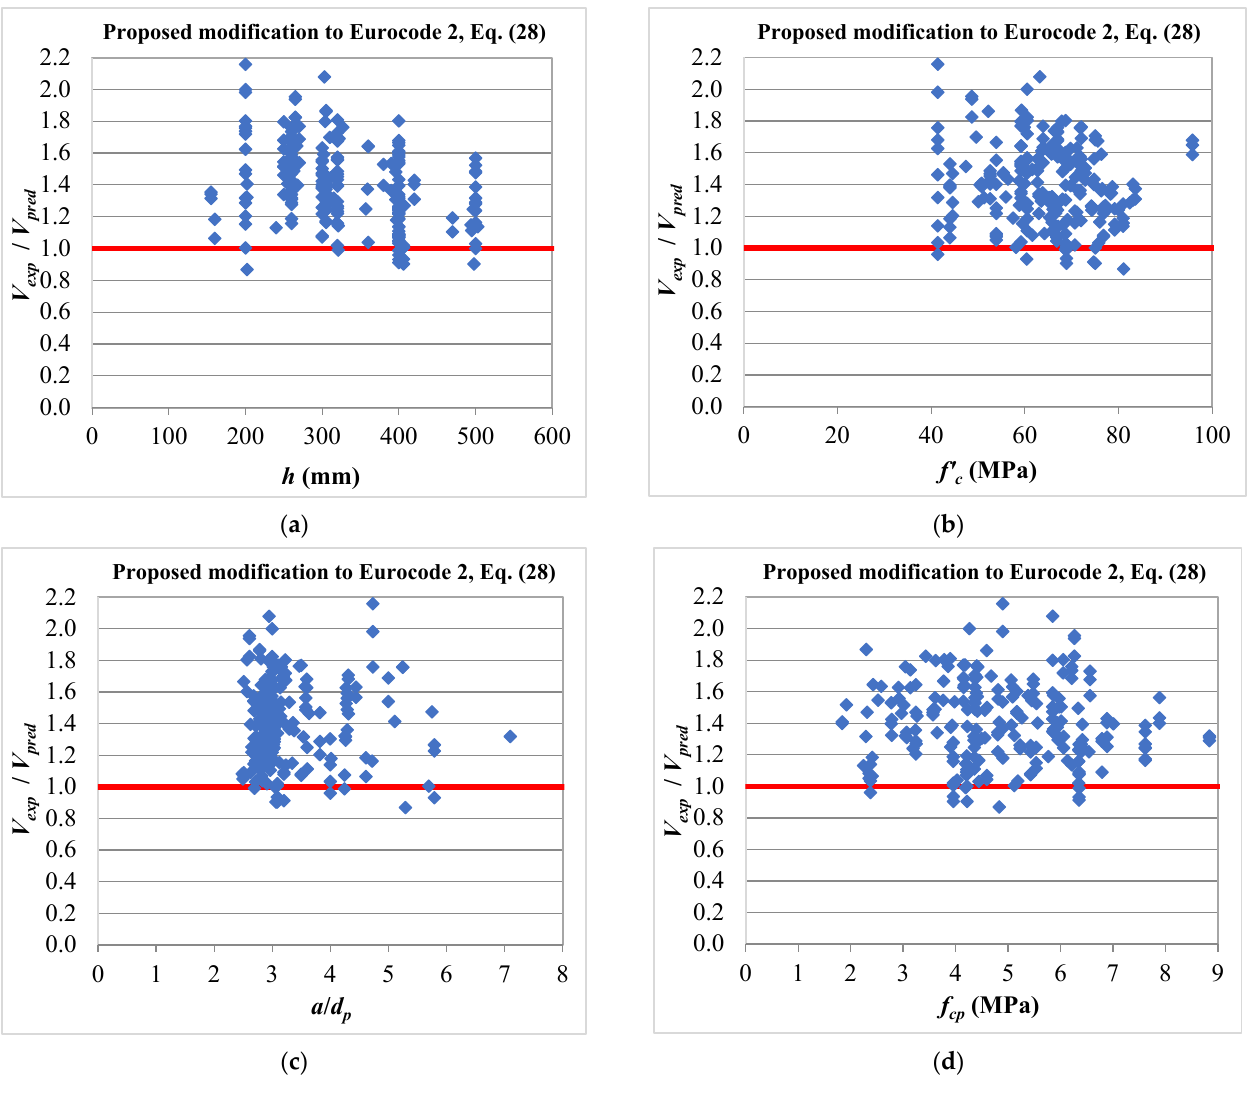
Figure 17. Predictions of Equation (28) against ( a ) total thickness, ( b ) concrete compressive strength, ( c ) shear span to depth ratio, and ( d ) compressive stress due to the fully effective prestressing force.